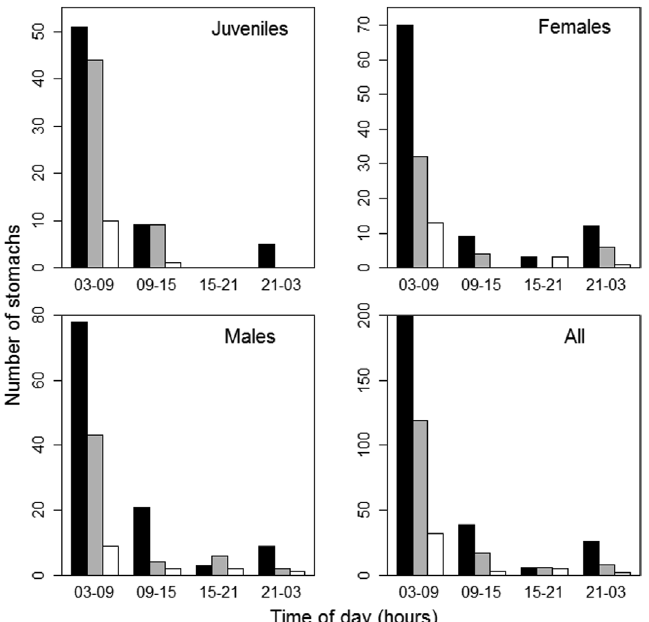
Figure 14. Stomach fullness frequency of Doryteuthis pleii collected during FAUNEC surveys per period of the day. Black bars: empty stomachs, grey bars: 50% full stomachs, white bars: 100% or distended